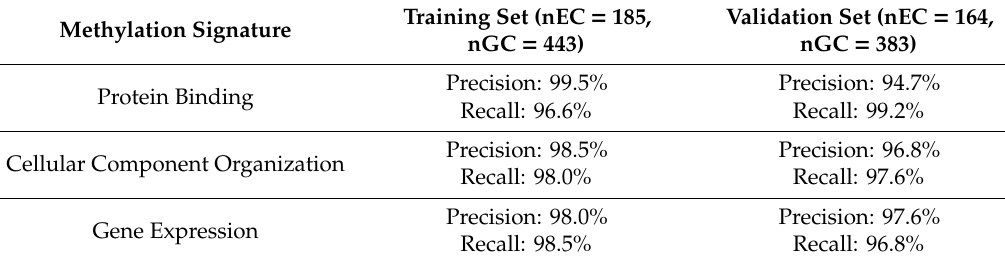
Table 5. Methylation signatures’ precision and